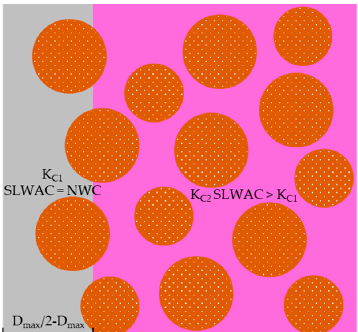
Figure 7. Biphasic carbonation model for SLWAC suggested by Bogas et al. [90]. The carbonation coefficient during the first stage is similar in SLWAC and NWC, while in the second stage tends to increase as the LWA porosity increases.